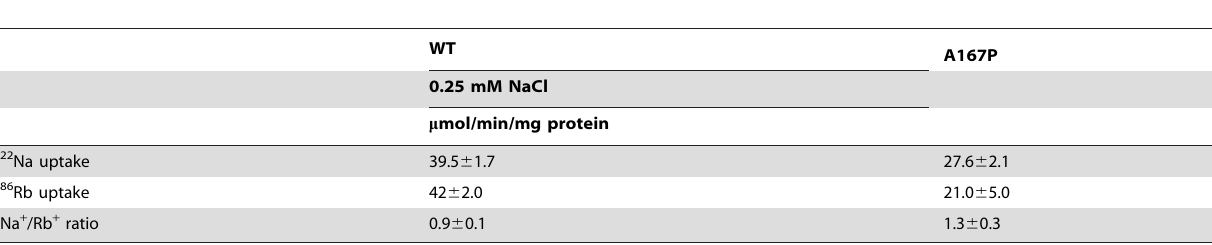
Table 2. Na + /Rb + uptake ratio indicates A167P electrogenicity.